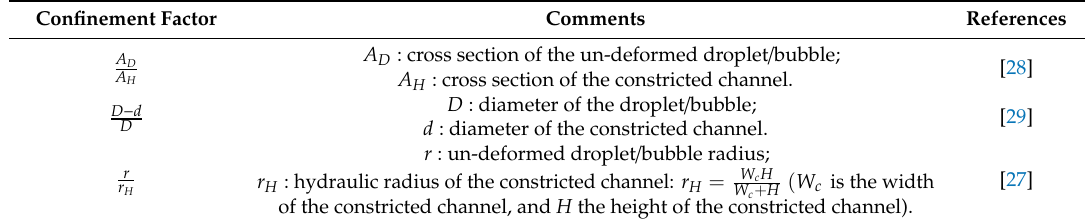
Table 2. Analytical expressions that are available in the literature for the Confinement Factor of the